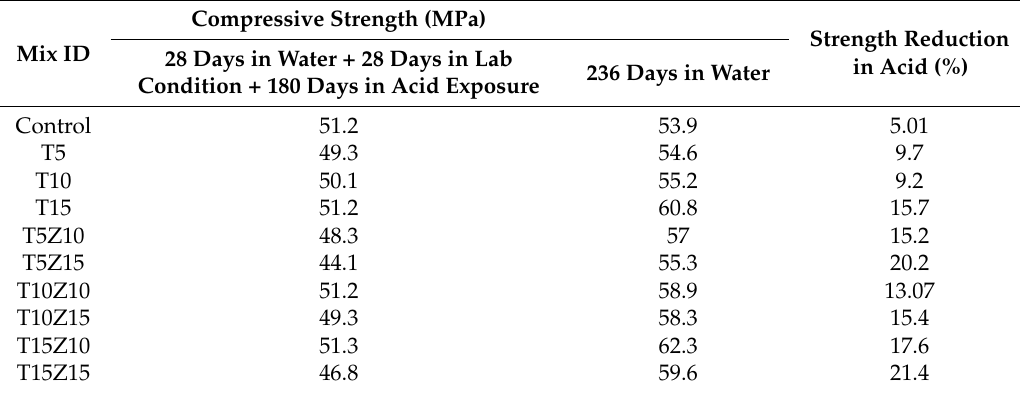
Table 4. Compressive strength after 236 days immersion in acid.